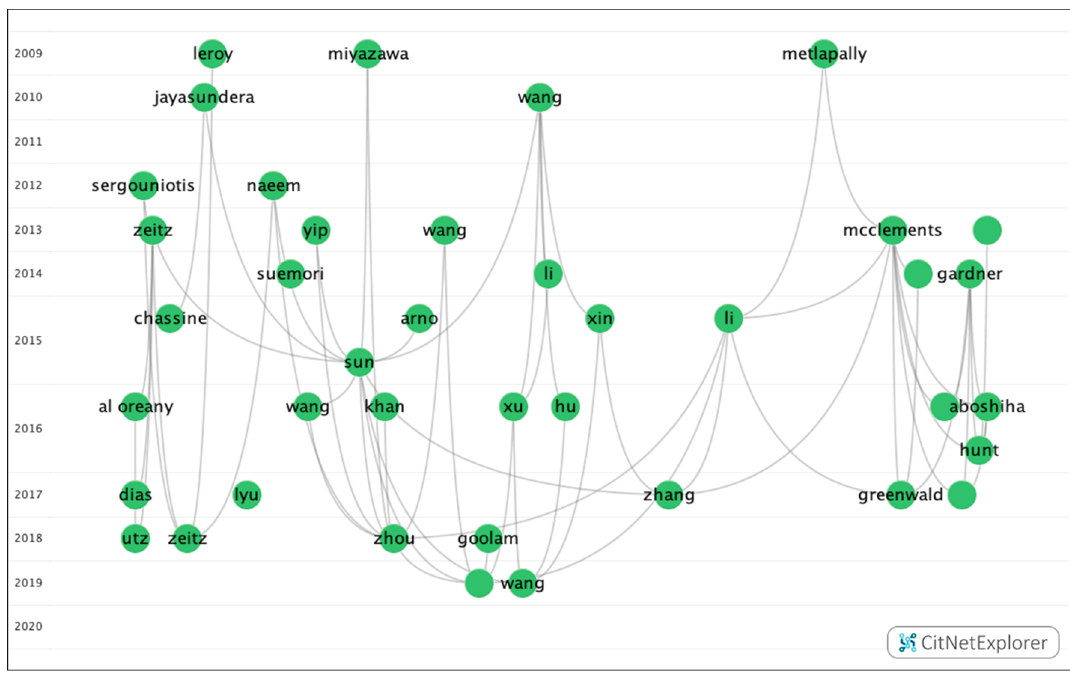
Figure 9. Citation network in group 2 .